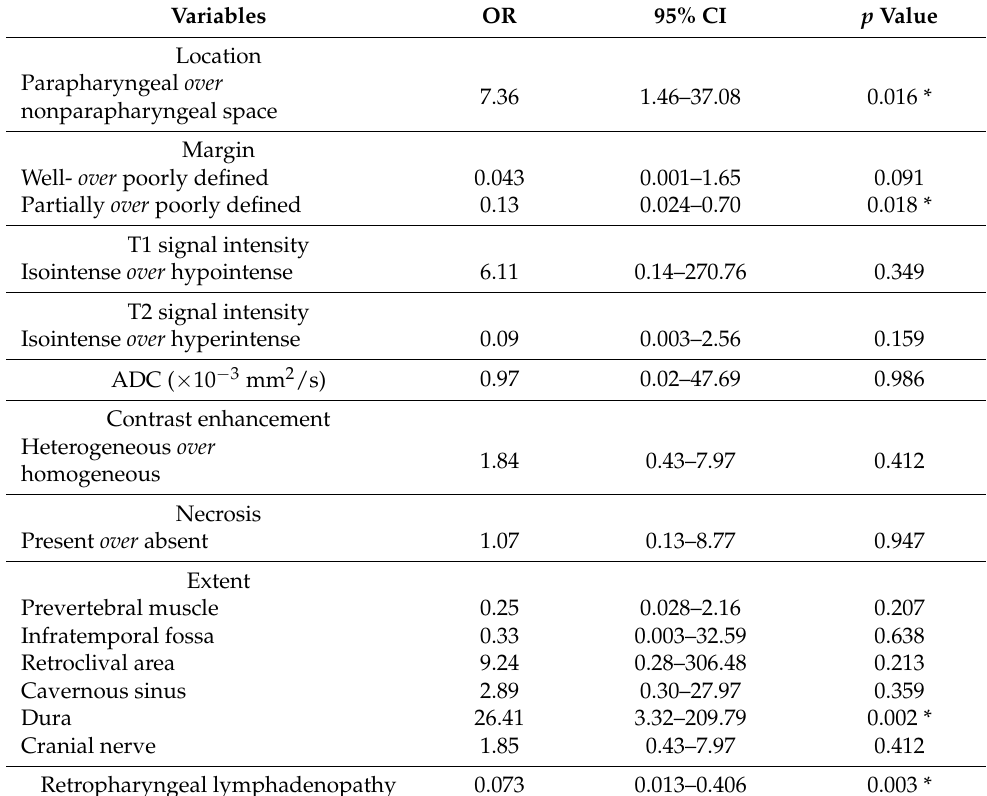
Figure 5. Comparison between GPA and NPC. ( a ) Axial contrast-enhanced T1WI of a 54-year-old female shows GPA lesion centered in the right parapharyngeal space, skewed laterally from the nasopharynx (arrow). Its infiltrative enhancement causes a poorly defined margin. ( b ) On the contrary, NPC lesion in a 46-year-old female shows enhancing lesion in the right lateral and posterior nasopharynx (arrow). Although it extends into adjacent parapharyngeal space, the lesion is centered in the nasopharyngeal wall. In addition, the margin of NPC is relatively well-defined compared to that of GPA lesion. Table 4. Univariable analysis for differentiating GPA from